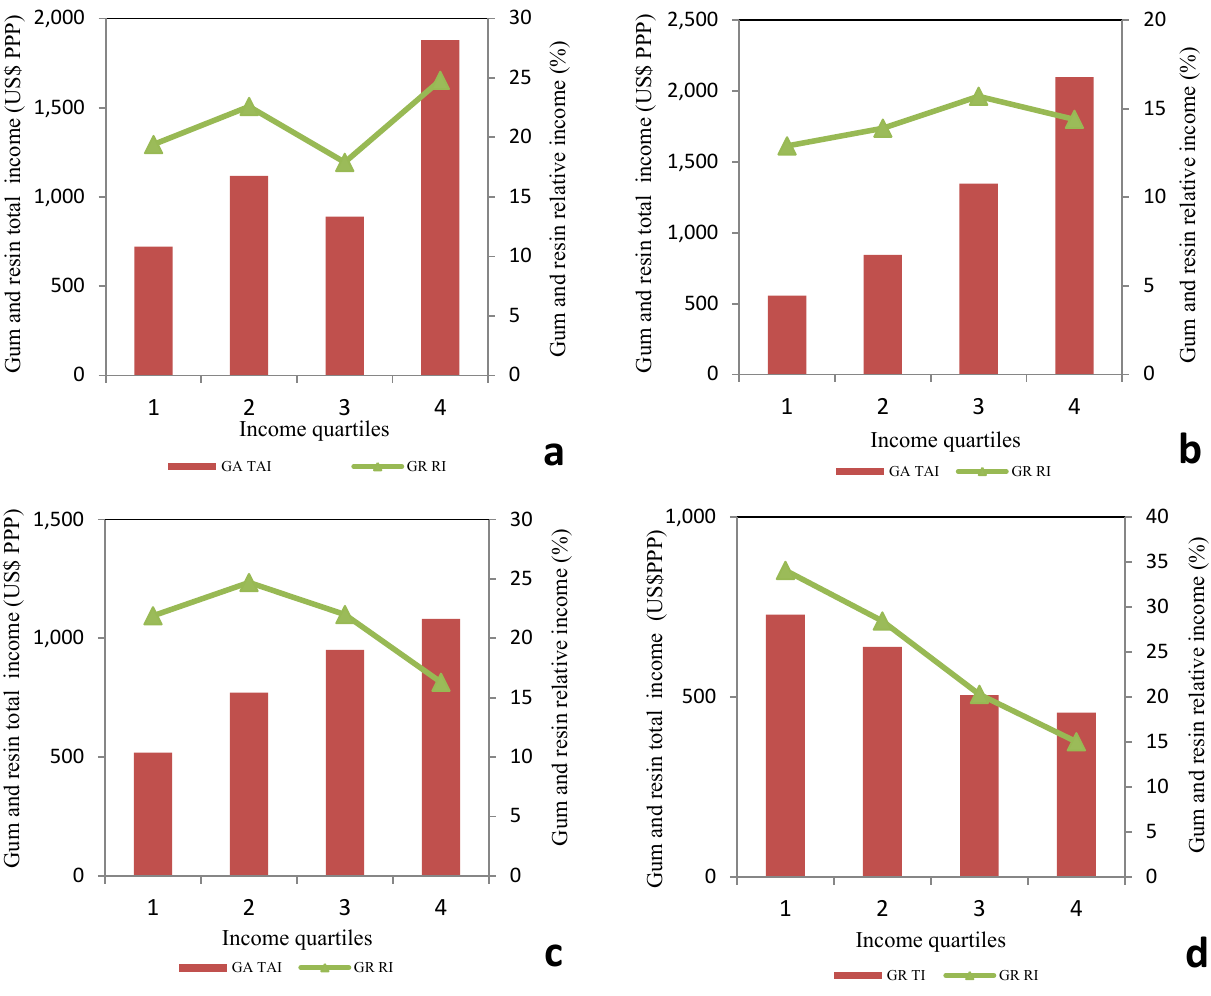
Figure 4. Absolute (TAI) and relative (RI) gum and resin income differentiated by income quartile groups across the case study areas ( a ) Ummrawaba ( b ) Elnehud ( c ) Abergelle and ( d ) Borena; n = 60 in all the